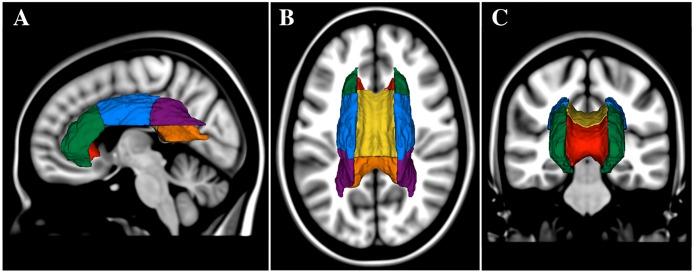
Relative spatial location of the regions of interest analyzed.Three-dimensional models of the sub-regions of the corpus callosum and corona radiata are illustrated. Models were produced in Slicer 3D (slicer.org) using the MNI white matter parcellation map and they are shown overlaid on the MNI brain in sagittal (A), axial (B) and coronal (C) views. Regions shown are the anterior corona radiata (ACR, green), superior corona radiata (SCR, blue), posterior corona radiata (PCR, purple), genu of corpus callosum (GCC, red), body of corpus callosum (BCC, yellow), and splenium of corpus callosum (SCC, orange). Views are from left (A), top (B) and front (C) of head. For the regional assessment of the diffusion indices we used a mask with skeletonized ROIs in the subject native space.